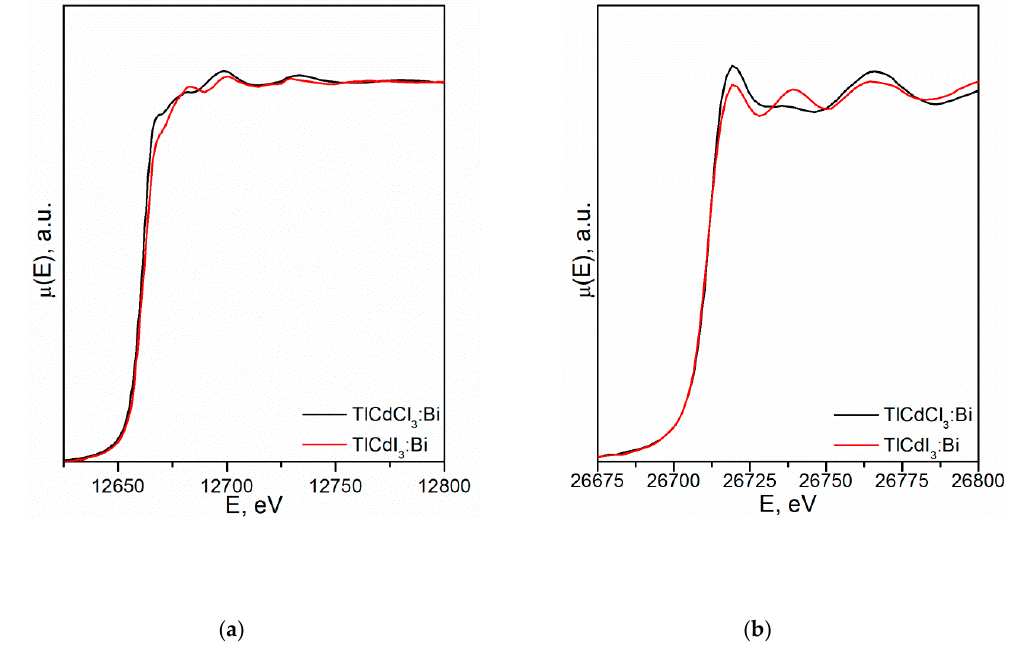
Figure 17. XANES spectra measured ( a ) at the Tl L 3 -edge and ( b ) at the Cd K-edge for TlCdCl 3 :Bi and TlCdI 3 :Bi crystals.